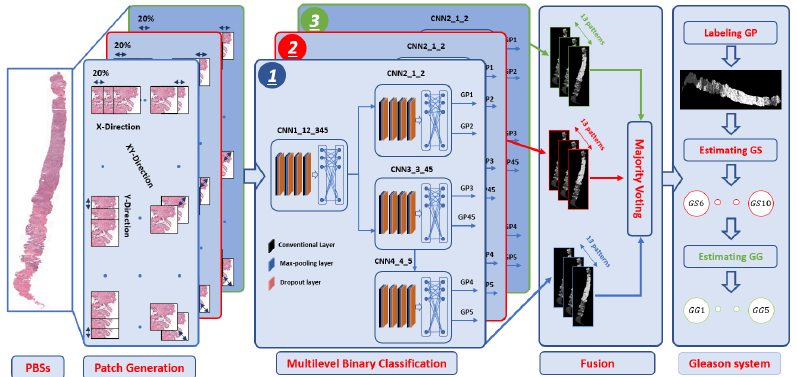
Figure 2. The proposed pipeline: PBSs is the digitized prostate biopsy specimens, GP is the Gleason pattern, GS is the Gleason score, and GG is the grade group.